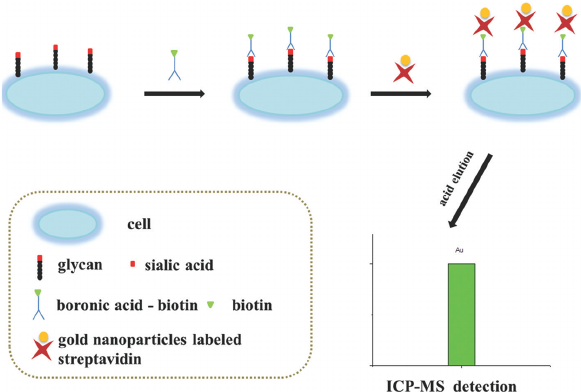
Figure 12: Illustration for recognition of SA on the cell surface assay. Reproduced with permission from [63]. Copyright 2016, The Royal Society of Chemistry